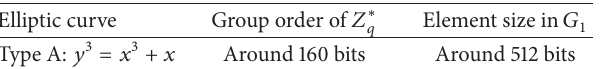
Table 3: Detailed elliptic curve and pairing parameters.